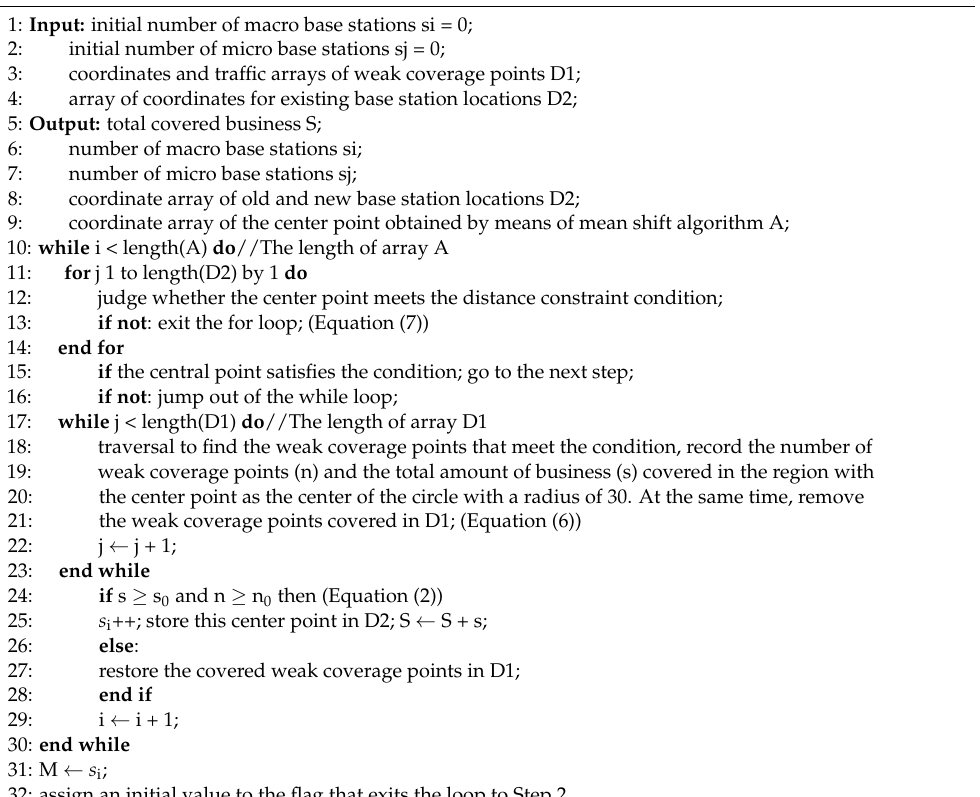
Algorithm 1: Algorithm for determining the number of macro base